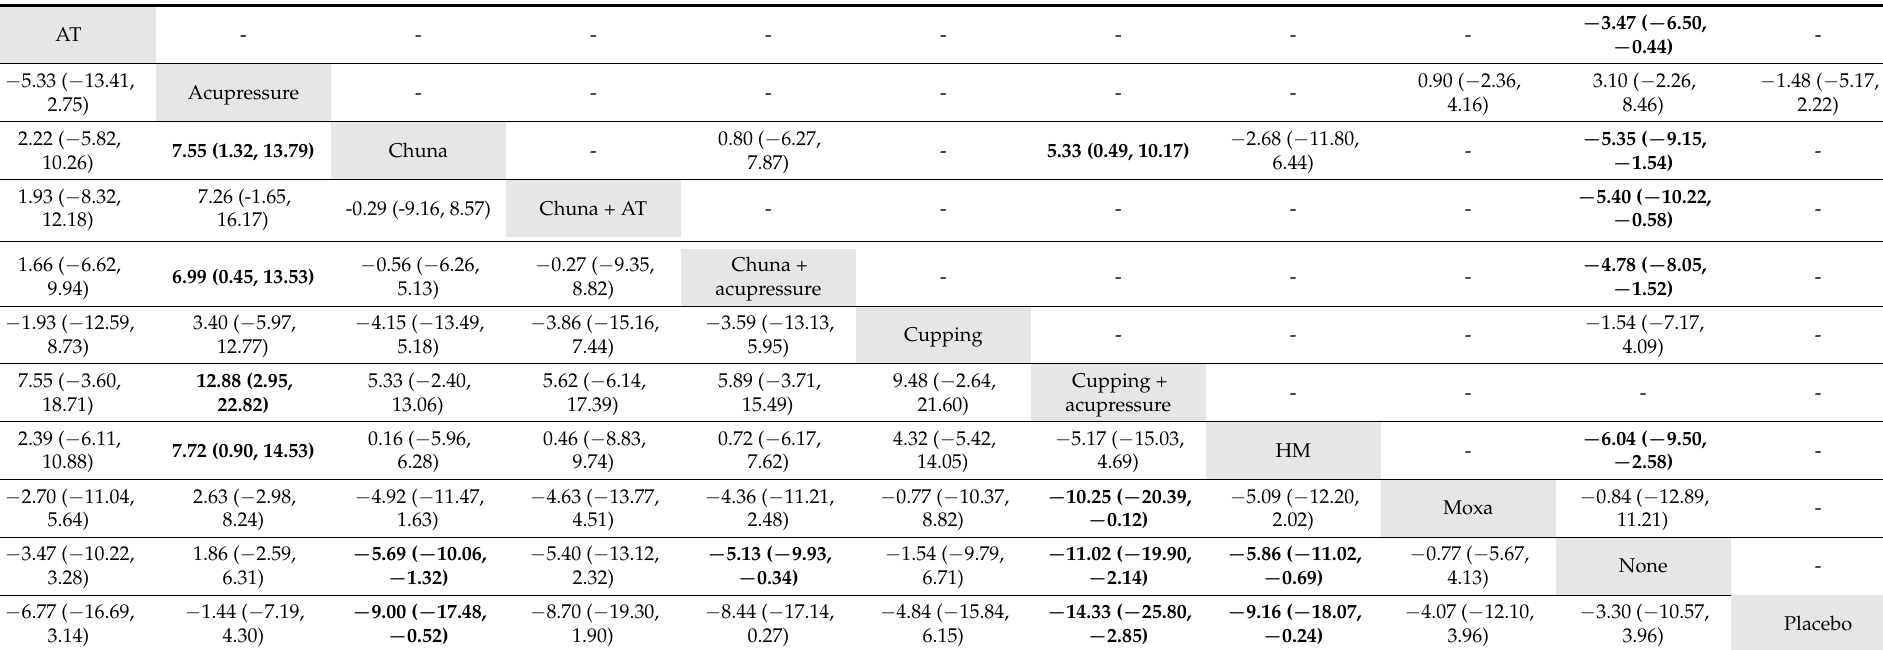
Results are presented as the mean difference (95% confidence interval). The comparison must be read from left to right. A mean difference less than zero indicates that treatment on the left is favored in both pairwise and network meta-analyses. Bold value means a significant difference between the groups. AT = acupuncture, HM = herbal medicine, Moxa = moxibustion, and None = non-medical